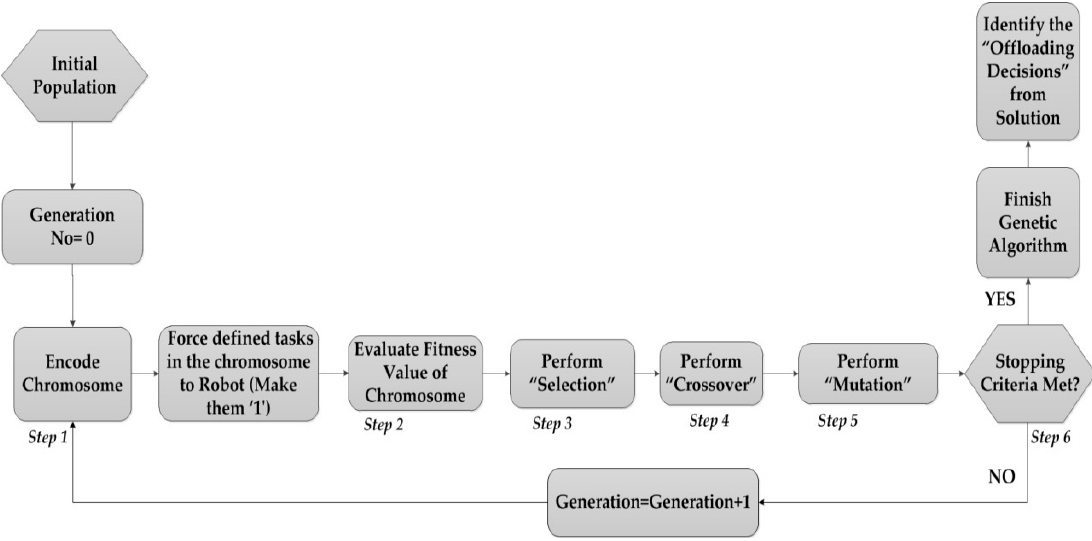
Figure 3. A flow-chart of the genetic algorithm based scheme.